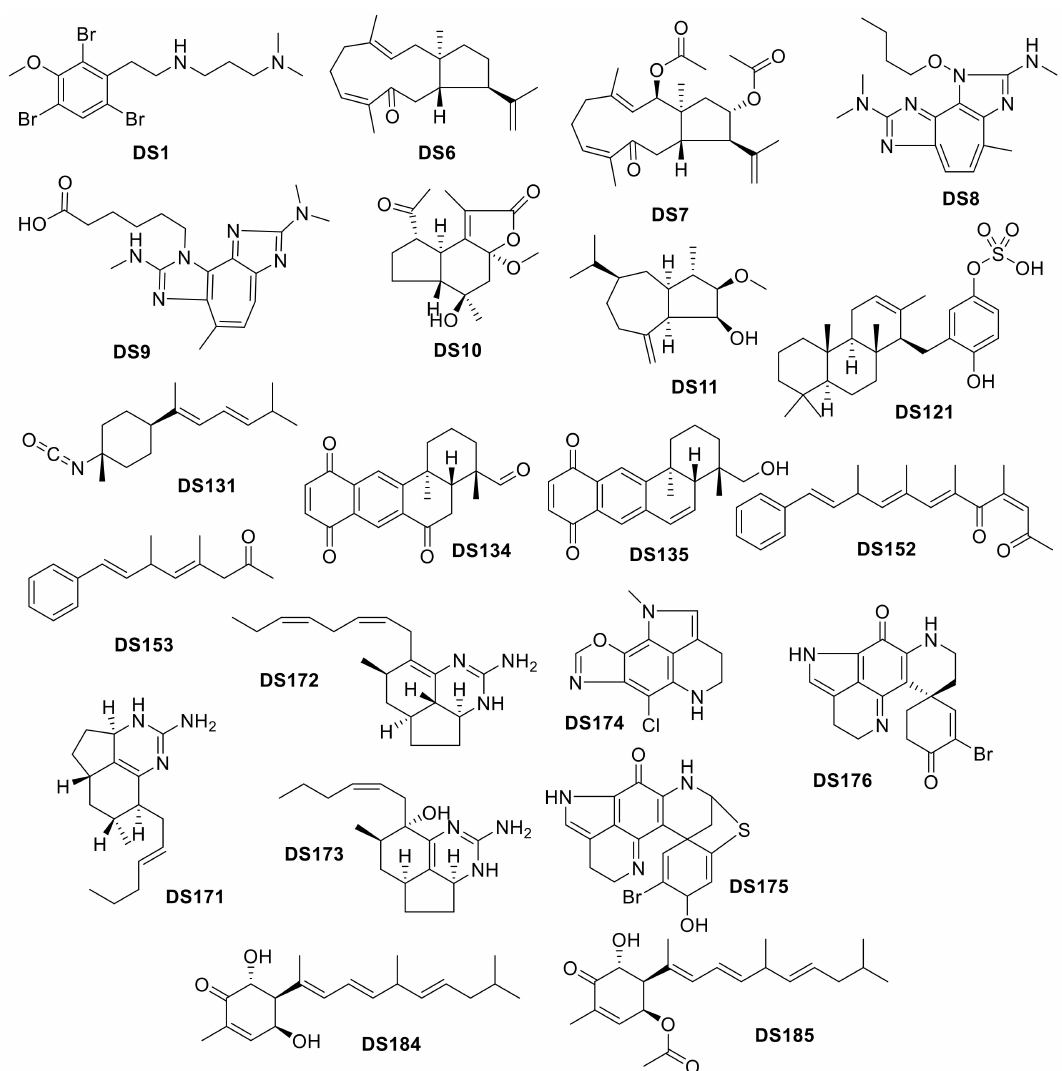
Figure 21. Drug-like compounds isolated from deep-sea Animalia